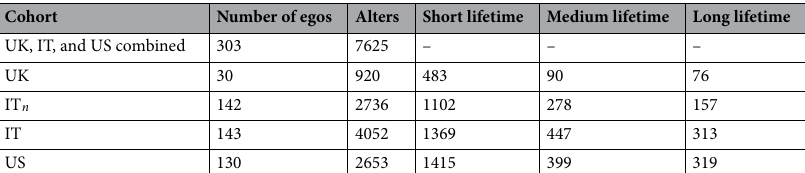
Cohort Number of egos Alters Short lifetime Medium lifetime Long lifetime UK, IT, and US combined 303 7625 – – – UK